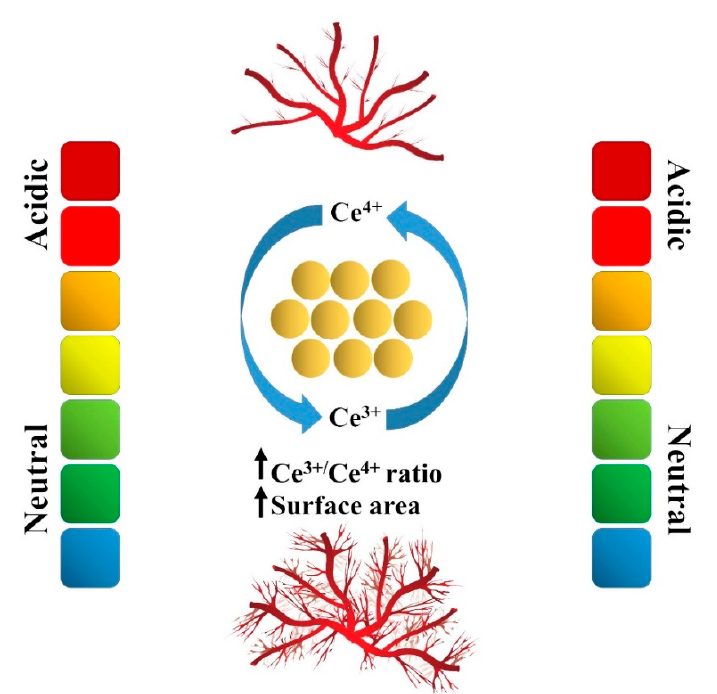
Figure 2. Schematic representation showing the impact of the environment on the angiogenic capacity of cerium oxide nanoparticles (CNPs). The environmental pH, reactive oxygen species (ROS) generation, and intracellular oxygen concentration determine the pro- or antiangiogenic behavior of CNPs. Reproduced from [86] .